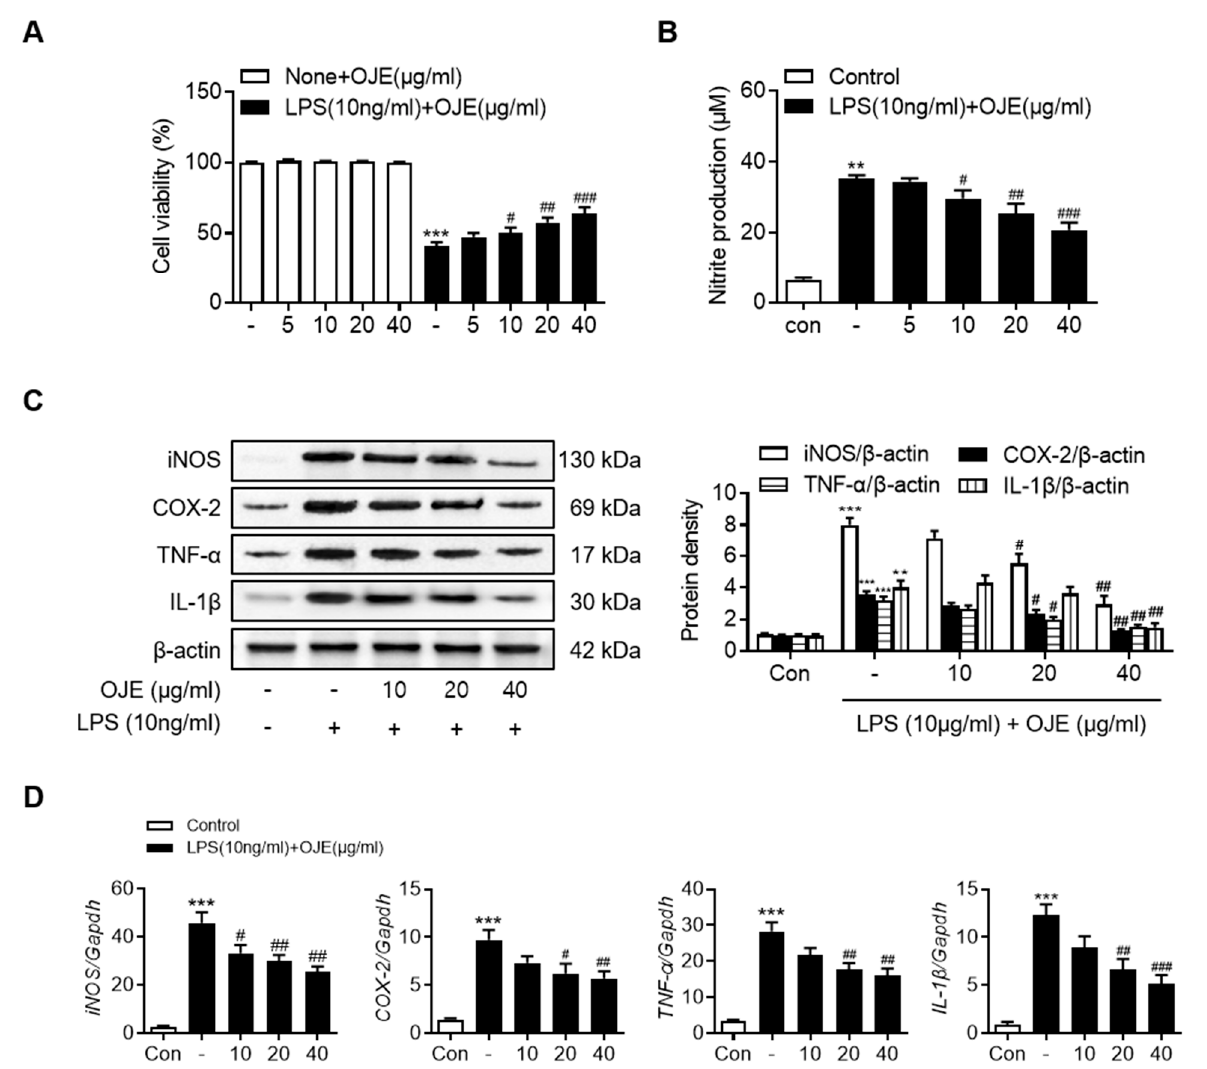
Figure 2. Effect of OJE on ( A ) cell viability ( B ) NO generation and mRNA and protein expression of iNOS, COX–2, TNF −α and IL–1 β by ( C ) Western blotting, and ( D ) RT–qPCR in LPS–stimulated Raw 264.7 cells. The data are shown as the mean ±SD (n = 8). ** p < 0.01, *** p < 0.001 vs. normal (control); # p < 0.05, ## p < 0.01, ### p < 0.001 vs. LPS–stimulated Raw 264.7 cells without OJE.